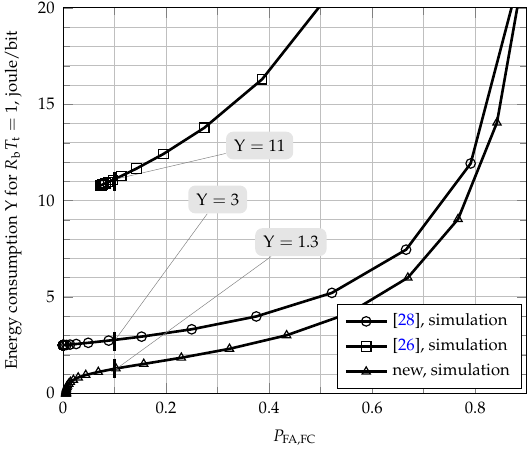
Figure 8. Lowest energy consumption per R b T t fair opportunistic transmitted bits (highest energy efficiency), for M = 5, K = 1 and C = 0.5 for the new fusion scheme, K = 3 and C = 0.5 for the scheme of [28] and K = 3 for the scheme of